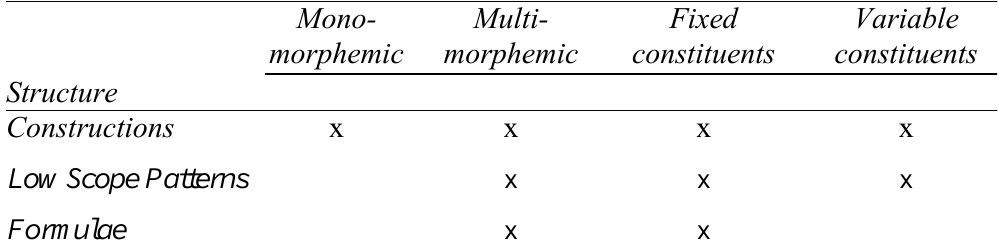
Distinctive Features of Constructions, Low Scope Patterns, and